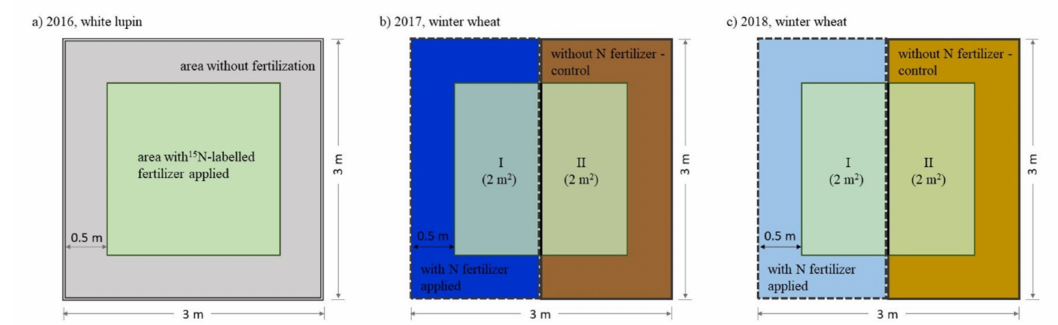
Figure 1. Scheme of plots experiment in each year. ( a ) 2016: in spring white lupin was sown on a plot of 9 m 2 (square with double line); on green area (2 m × 2 m = 4 m 2 ) 15 N-labeled fertilizer was applied during the white lupin vegetation season. In the experiment the 15 N-labeled fertilizer, ( 15 NH 4 ) 2 SO 4 , using a dosage of 30 kg N ha − 1 was applied; gray area—area without fertilization. White lupin was next harvested only from the green area. In autumn 2016 whole area (9 m 2 ) was sown by winter wheat; ( b ) 2017: in spring, the original plot (9 m 2 ) was divided into two subplots with equal area (4.5 m 2 ). On the first subplot (blue area, dashed line), a dose of 100 kg N ha − 1 of N fertilizer was applied; on the second subplot (brown area, solid line), N-fertilizer was not used (control). Winter wheat was then harvested from each subplot from a 2 m 2 area (marked as I and II), where in 2016 the 15 N-labeled fertilizer was applied. In autumn 2017, the whole area (9 m 2 ) was sown with winter wheat; ( c ) 2018: in spring, the original plot (9 m 2 ) was divided into two subplots with equal area (4.5 m 2 )—the same as previous year. On the first subplot (light blue area, dashed line), a dose of 100 kg N ha − 1 of N fertilizer was applied; on the second subplot (light brown area, solid line), N-fertilizer was not used (control). Winter wheat was then harvested from each subplot from a 2 m 2 area (marked as I and II), where in 2016 the 15 N-labeled fertilizer was